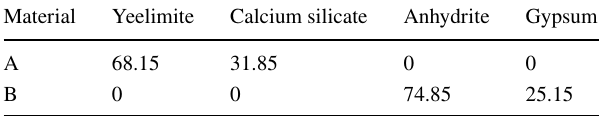
Table 1 Comparison of chemical composition of materials of A and B in high-water material (%)